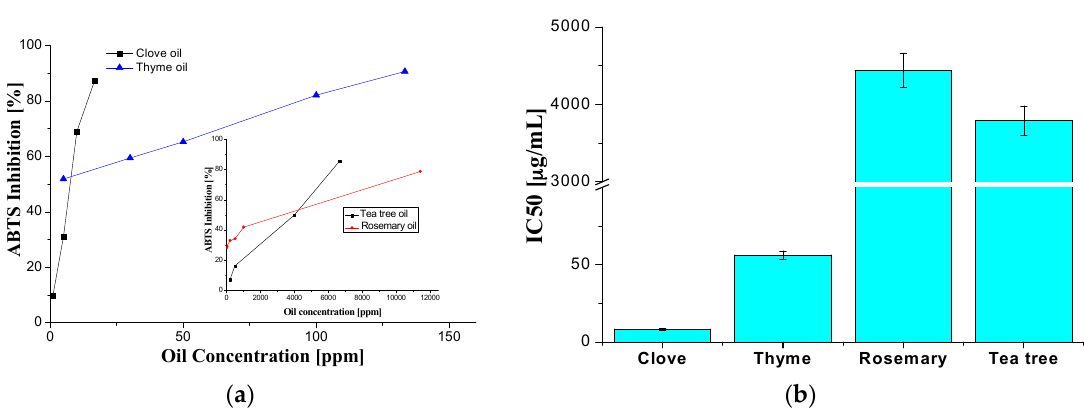
Figure 9. ABTS radical discoloration of studied essential oils ( a ) and the values of sample concentration required to scavenge 50% of the ABTS free radicals (IC50); ( b ) of selected essential oils. Materials 2017 , 10 , 45